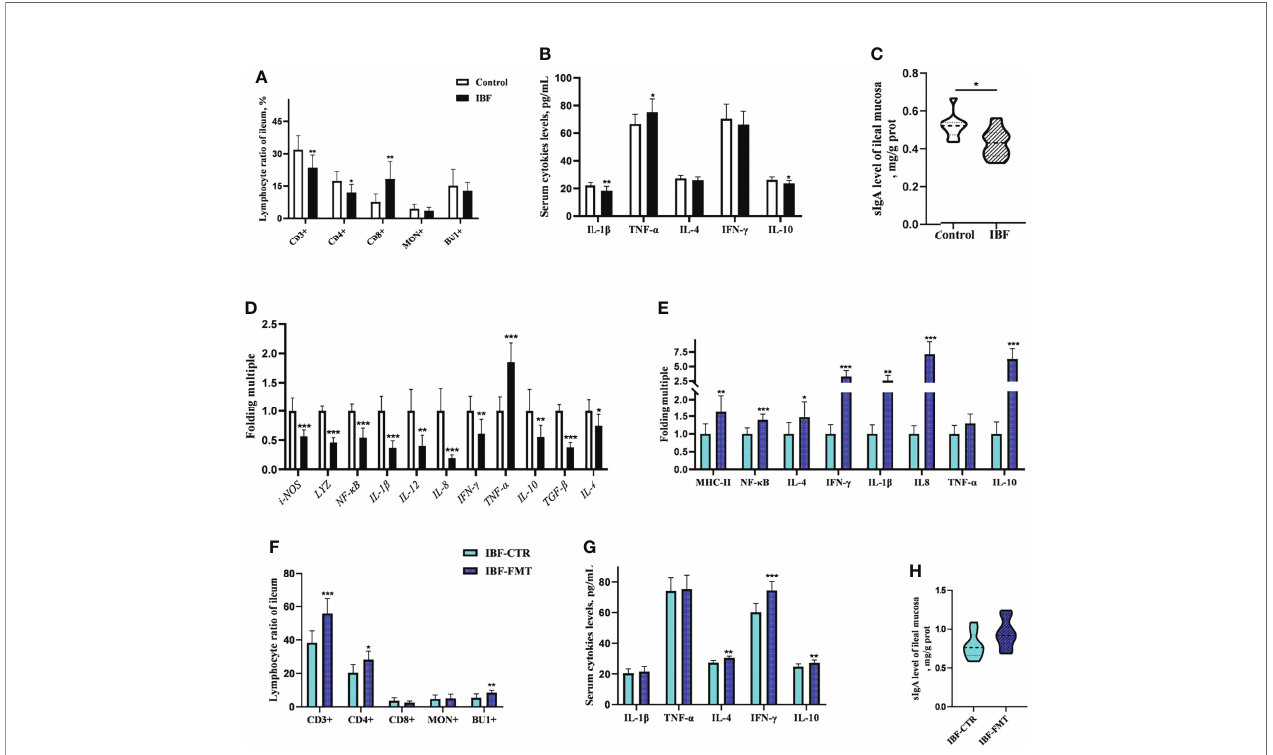
FIGURE 3 | Effects of FMT on intestinal immune function in IBF chickens. The results of the comparative study of control and IBF chickens were shown in panels (A – D) (n= 10), and the comparison results between IBF-CTR and IBF-FMT chickens were shown in panels (E – H) (n= 8). Among them, * means that the data tends to be different (0.05< P< 0.1), ** represents a signi fi cant difference (0.001< P< 0.05), and *** represents an extremely signi fi cant difference (P< 0.001), the same